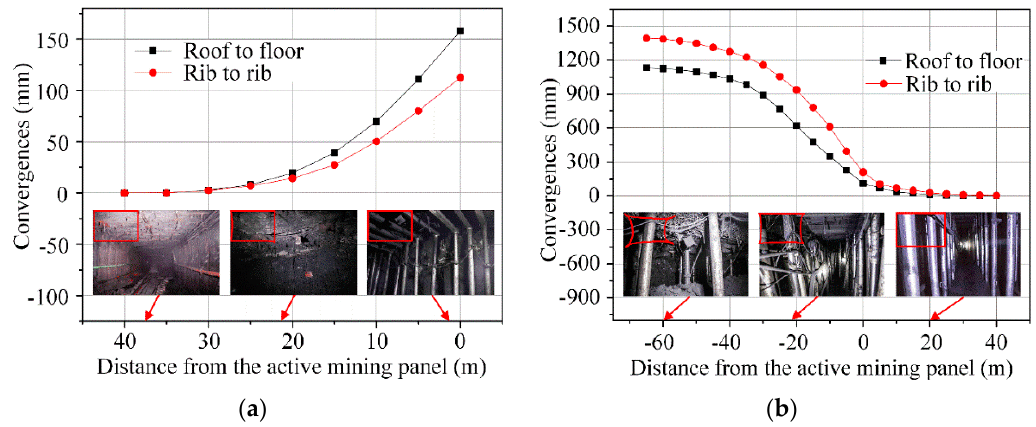
Figure 4. Roadway deformation characteristics during the 6212 mining panel retreating: ( a ) 6212 tail entry; ( b ) 6208 tail entry.